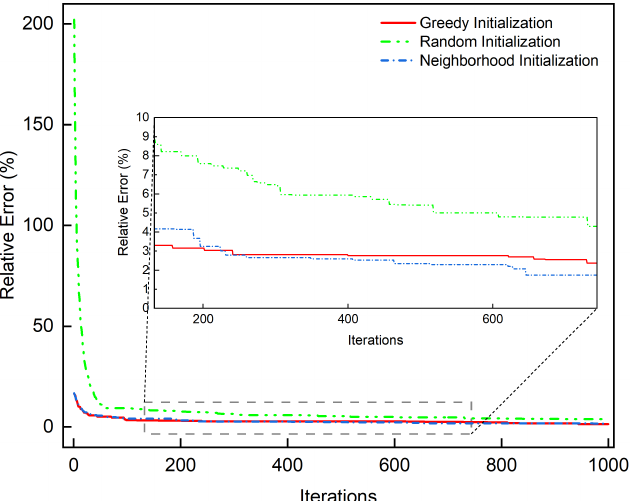
Figure 9. RE curves with random initialization, neighborhood initialization, and greedy initialization for different iteration periods based on